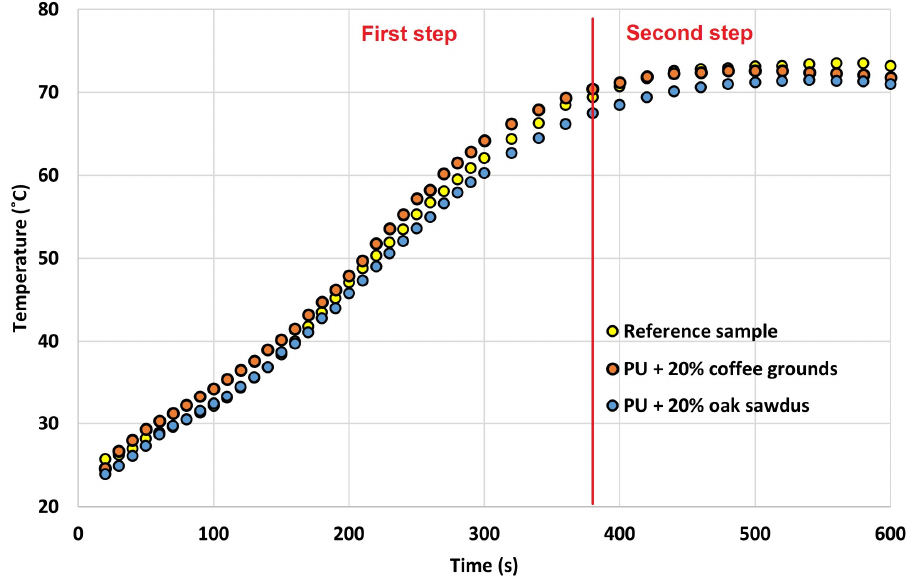
Figure 3. Temperature as a function of time during foam expansion of the reference sample and polyurethane composites.